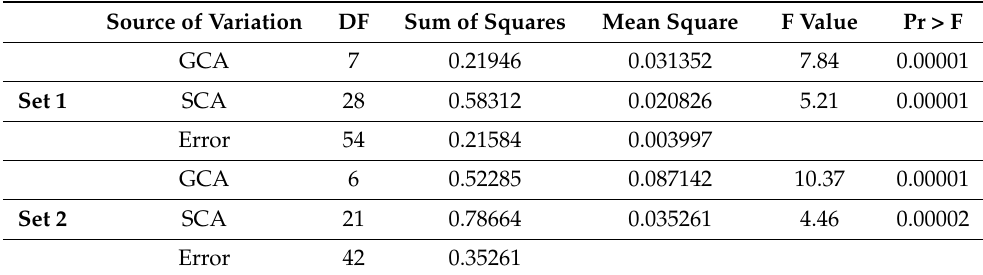
Table 7. Griffing’s analysis of variance of market yield for Set 1 and 2. DF = degrees of freedom. Pr = p -value.